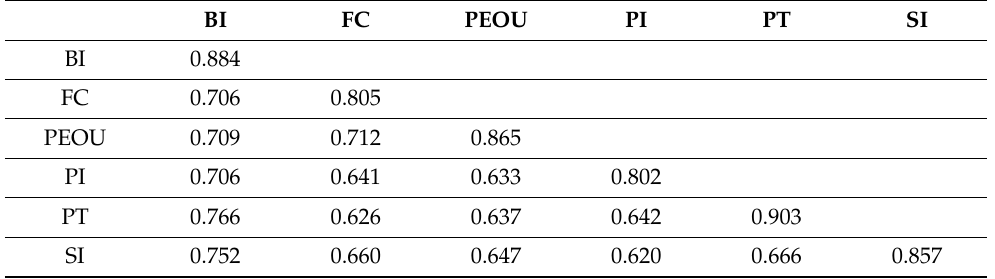
Table 4. Fornell–Lacker